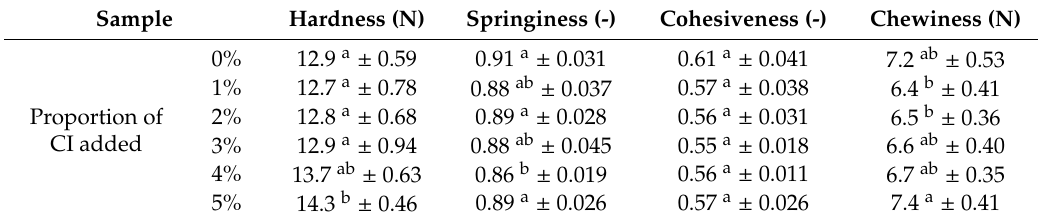
Table 2. Texture parameters of bread samples enriched with Cistus incanus L.